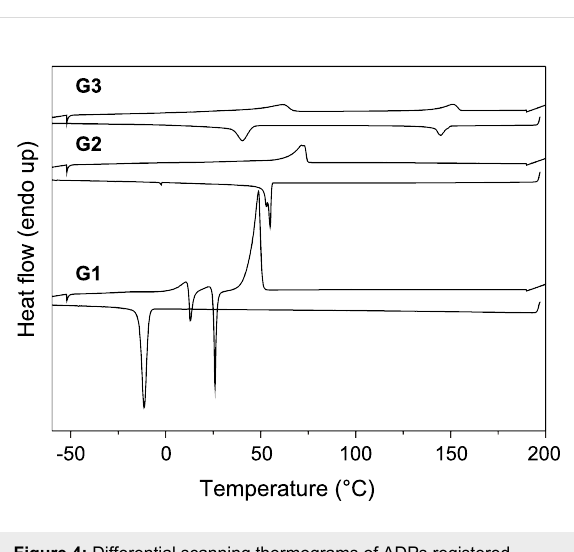
Figure 4: Differential scanning thermograms of ADPs registered during the second heating–cooling cycle with scanning rate 10 K min − 1 .